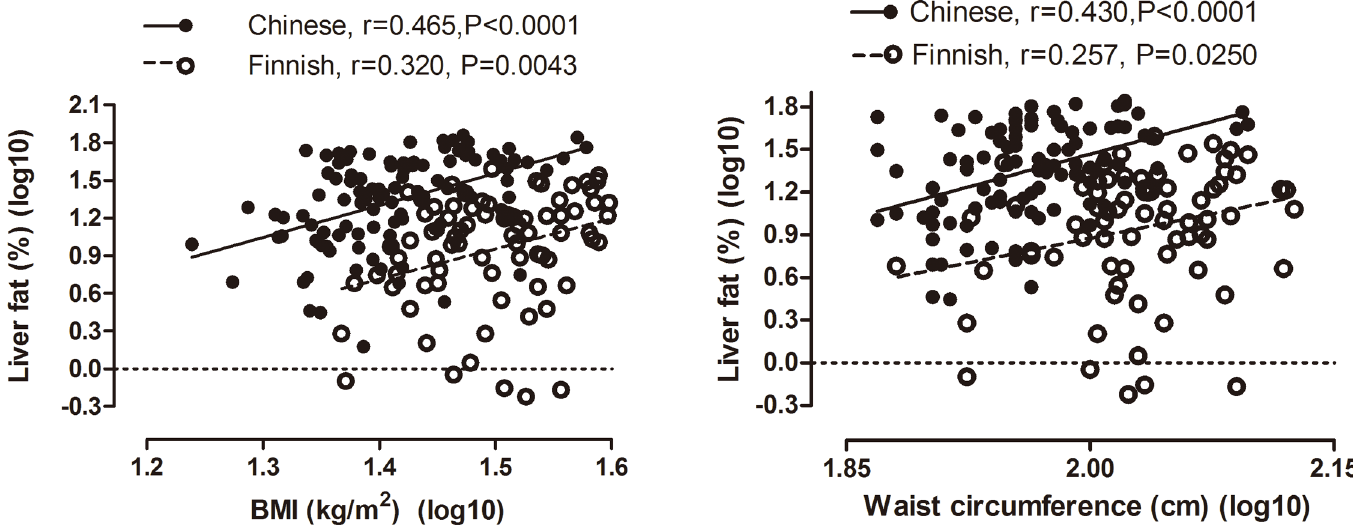
Fig 2. Relationships between liver fat (%), BMI (panel on the left) and waist circumference (panel on the right) in Chinese and Finns. There were no differences between the slopes of the regression lines relating BMI (P = 0.865) and waist circumference (P = 0.514) to 1 H-MRS LFAT between the Chinese and Finns. The intercepts of the regression lines relating BMI (P < 0.0001) and waist circumference (P < 0.0001) to 1 H-MRS LFAT were significantly higher in the Chinese than the